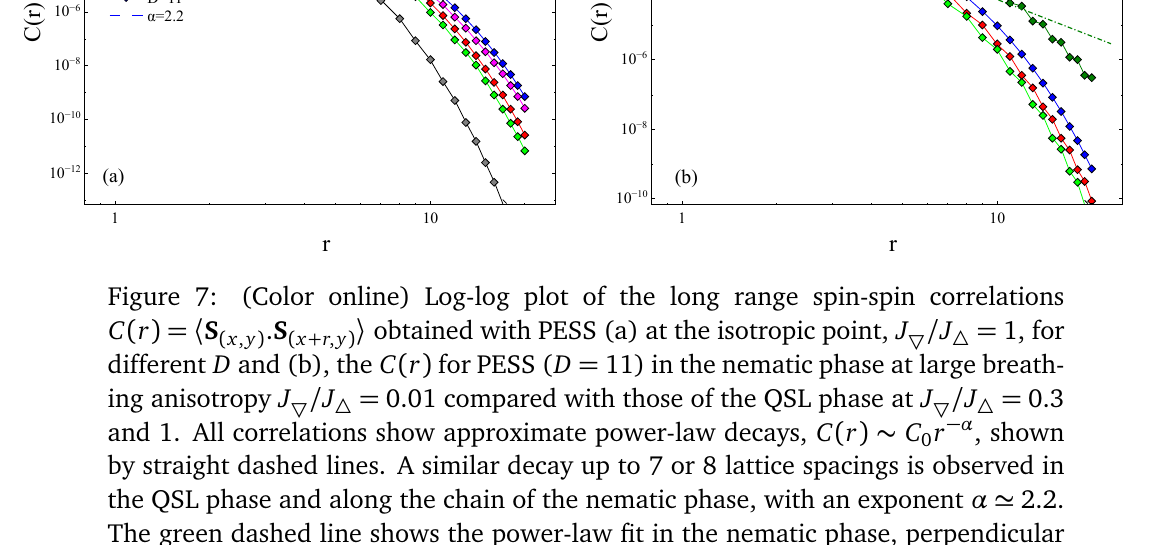
/ J = 1, for (cid:53) (cid:52) r − α , shown 0